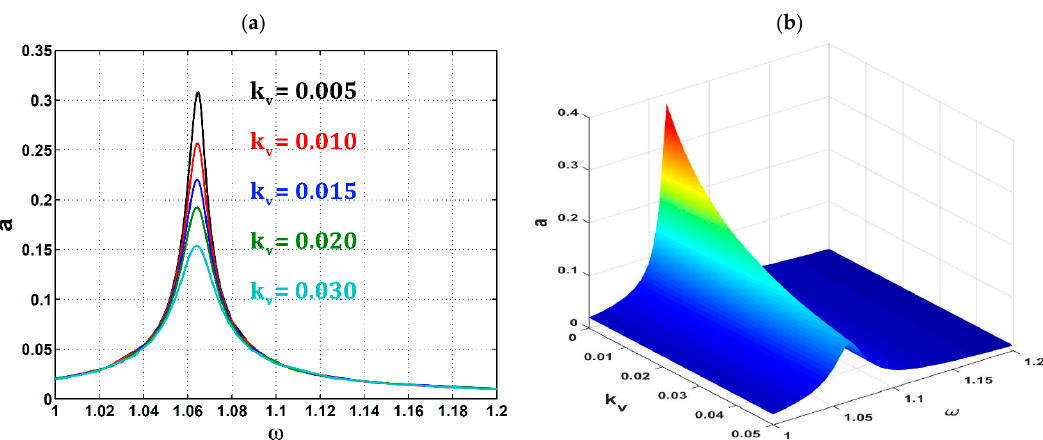
Figure 10. Relationship between the car’s oscillation amplitude a and ( a ) the excitation frequency ω at different values of NV control gain k v , ( b ) both the excitation frequency ω and NV control gain k v post-control ( k p = 0.6).